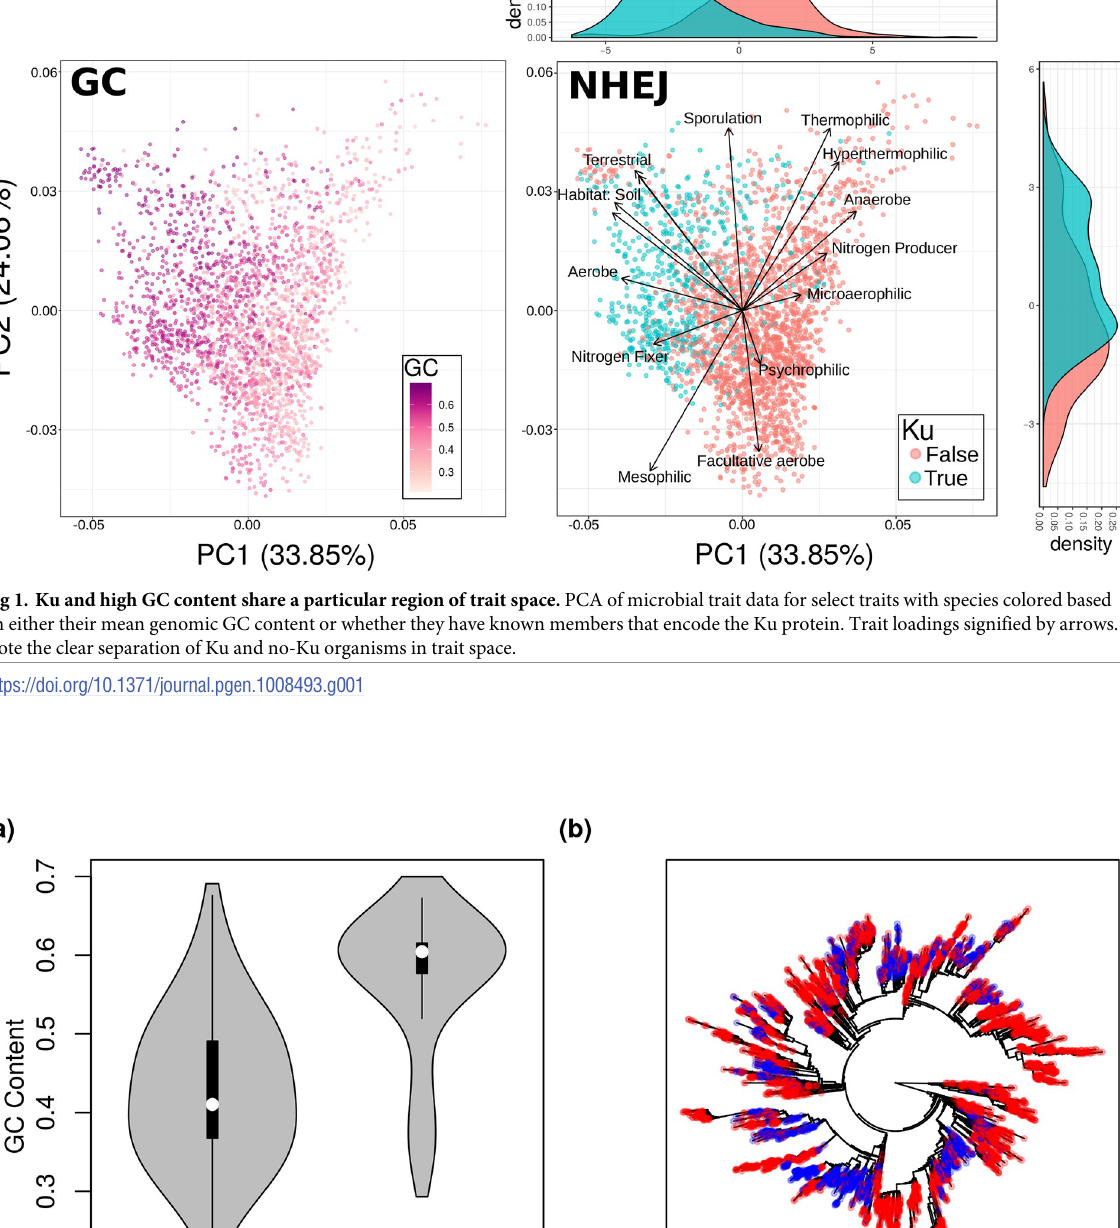
PLOS Genetics | https://doi.org/10.1371/journal.pgen.1008493 November 8,